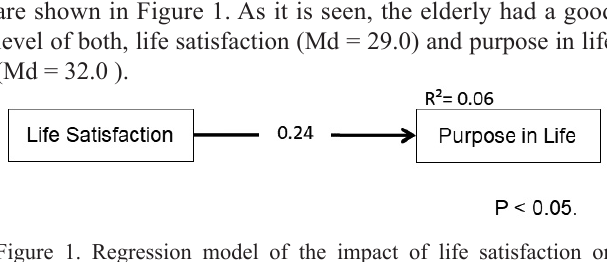
Figure 1. Regression model of the impact of life satisfaction on purpose in life of the elderly.